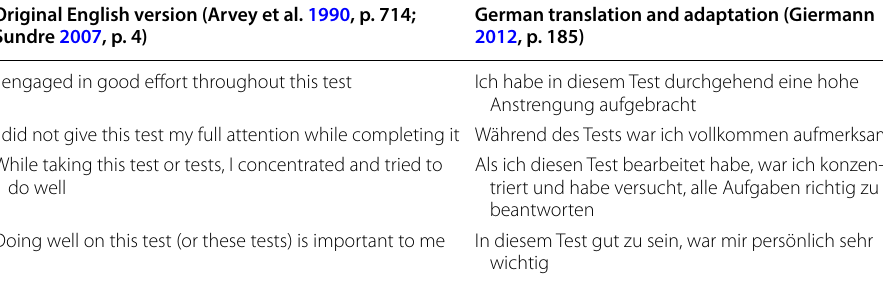
Table 3 Items for assessing test